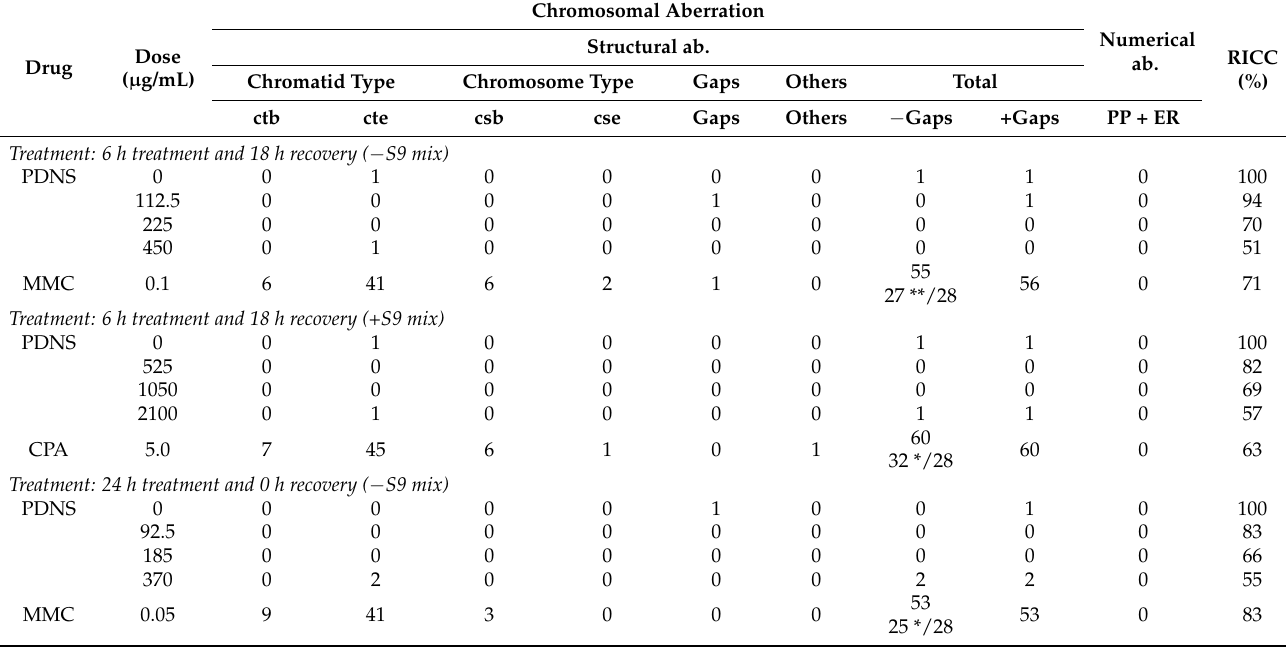
Table 5. Results of the chromosomal aberration test of powder of dried noni seeds.